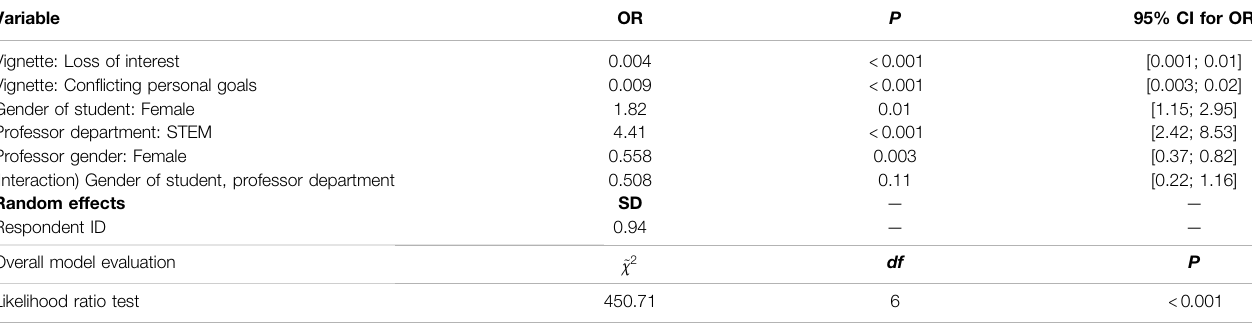
TABLE 2 | Logistic regression predicting whether a professor encourages an undergraduate to follow through with plans to go to physics graduate school, testing for whether the effectdue to whether a professor wasaf fi liated with STEM department(s) depends on undergraduate gender. We found no evidence of a conditional effect. Predictors were identical to those used for our fi rst model ( Table 1 ), with the added interaction term between undergraduate gender and STEM/non-STEM departmental af fi liation. The likelihood ratio test compares the target model to a null-intercept model. Number of total observations: 1,092. Number of encouraging observations: 692. Number of discouraging observations: 400. Number of respondents: 364. OR (cid:1) odds ratio, P (cid:1) p -value, 95% CI for OR (cid:1) 95% con fi dence interval for odds